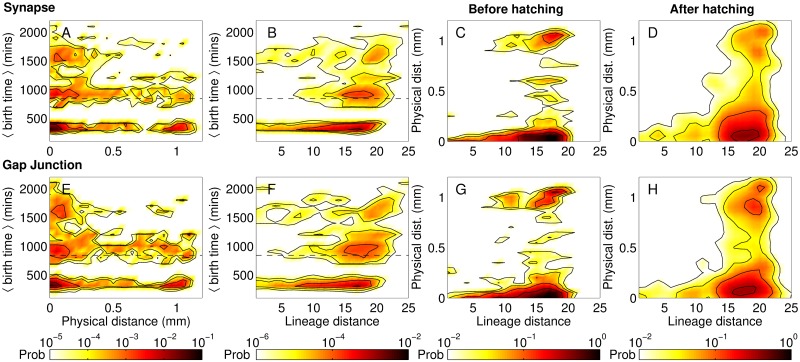
Birth times and lineage distances constrain connections between neurons whose cell bodies are spatially distant from each other.(A-B) The mean birth time of synaptically connected pairs of neurons exhibit a trimodal distribution, with connections clustering into three temporal groups corresponding to those (i) between neurons that are both born early, i.e., in the embryonic stage, (ii) between one born early and the other born late (i.e., in the post-embryonic stage), and (iii) between neurons that are both born late. The hatching time ht separating the embryonic from other developmental stages is indicated by the broken line. We note from panel (A) that when both neurons are born late (corresponding to the uppermost cluster of connections), synaptic connections are more likely to occur between neurons whose cell bodies are located close to each other. (C-D) Synaptic connections between neurons that are closely related to each other in terms of lineage (l < 10) occur almost always when their cell bodies are in proximity, regardless of the time of birth of the neurons. We note that this restriction is more pronounced than observed in Fig 2(E), where P(D, l) shows a prominent peak at the lower end of D for small l suggesting that most closely related neurons (whether connected or not) typically have short distances between their cell bodies. (E-H) Neurons connected by gap junctions show patterns similar to those seen in the case of synaptic connections.